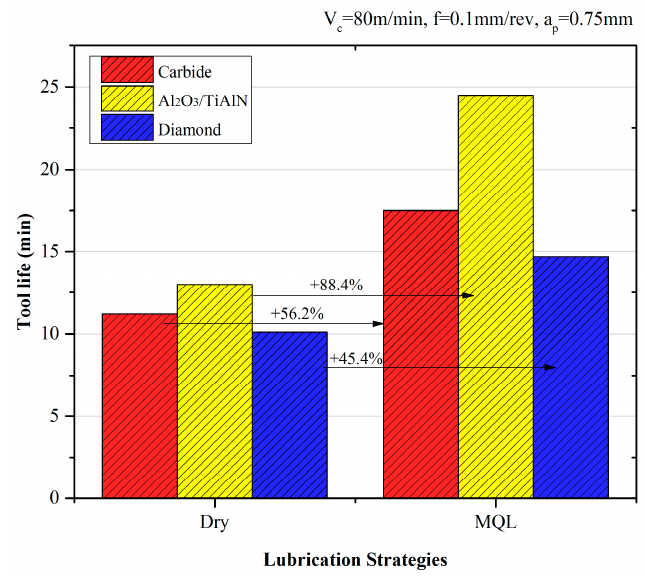
Figure 10. Tool life comparison of tools under dry and MQL conditions.